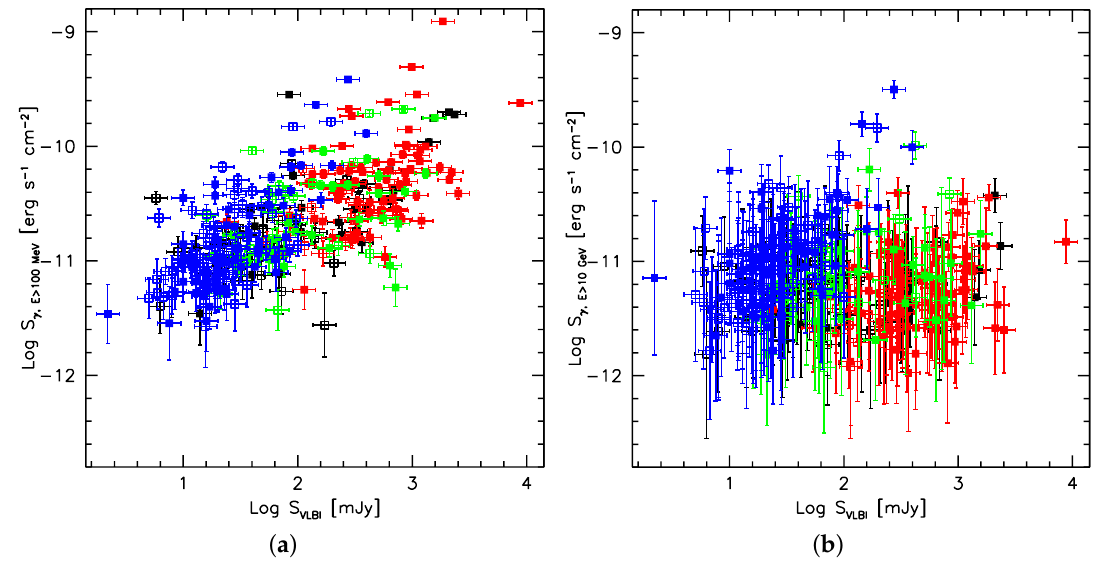
Figure 2. Gamma-ray energy flux at E > 100 MeV ( a ) or E > 10 GeV ( b ) vs. 5 GHz very long baseline interferometry (VLBI) flux density for the 1FHL sample. Blue: BL Lacs; red: flat spectrum radio quasars (FSRQs); green: blazars of uncertain type (BCU); black: misaligned active galactic nuclei